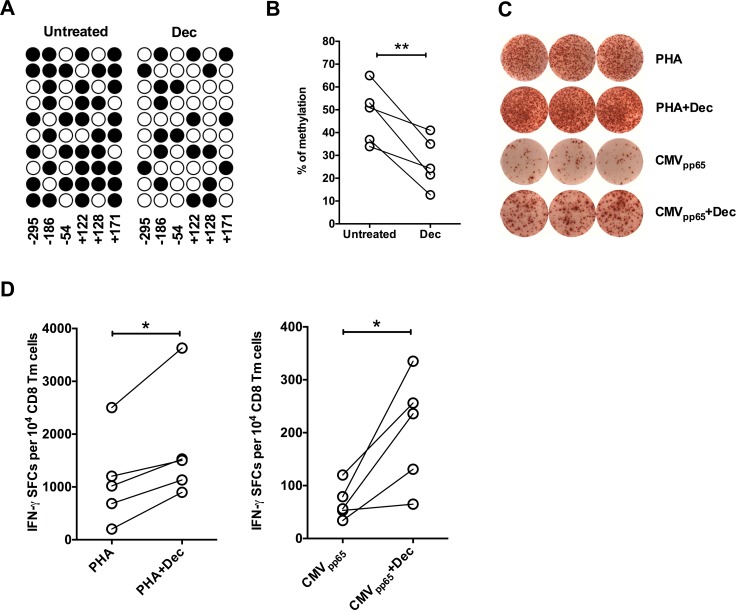
Impact of demethylation treatment on IFN-γ production by CD8 Tm cells from pregnant women.(A) Representative distribution of methylation at 6 CpG sites of IFN-γ gene promoter region before and after demethylation treatment (decitabine, Dec) is shown. Numbers refer to position relative to transcription start site. Filled circles represents methylated CpG and open circles represent demethylated CpG. (B) Average percentages of DNA methylation at 6 CpG sites of IFN-γ gene promoter region before and after demethylation treatment in PBMC CD8 Tm cells from five women at week 28 of pregnancy. (C) Representative graphs of triplicate IFN-γ ELISpot wells of CD8 Tm cells stimulated ex vivo with either PHA or T2 cells pulsed with CMVpp65 peptide, with or without demethylation treatment. (D) Statistics of IFN-γ spot forming CD8 Tm cells from five pregnant women, following ex vivo stimulation with PHA or T2 cells pulsed with CMVpp65 peptide, with or without demethylation treatment. Two-tailed paired Student’s t-test was used for statistical comparison between control and decitabine treatment groups. * P<0.05; ** P<0.01. The experiments were performed once.